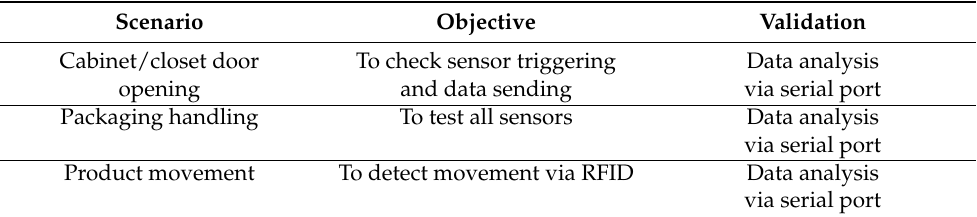
Table 4. Experimental evaluated scenarios and theirs